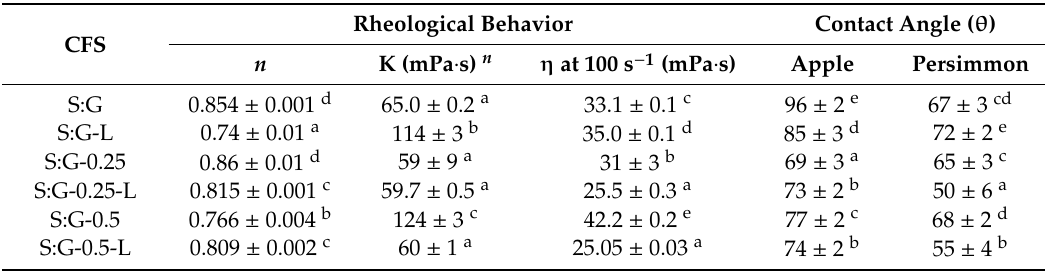
Table 1. Rheological parameters (flow behavior index, n; consistency index, K; apparent viscosity at 100 s − 1 , η ) and contact angle ( θ ) of the coating forming solution (CFS) on the skin of ‘Golden Delicious’ apple and ‘Rojo Brillante’ persimmon. Mean values and standard